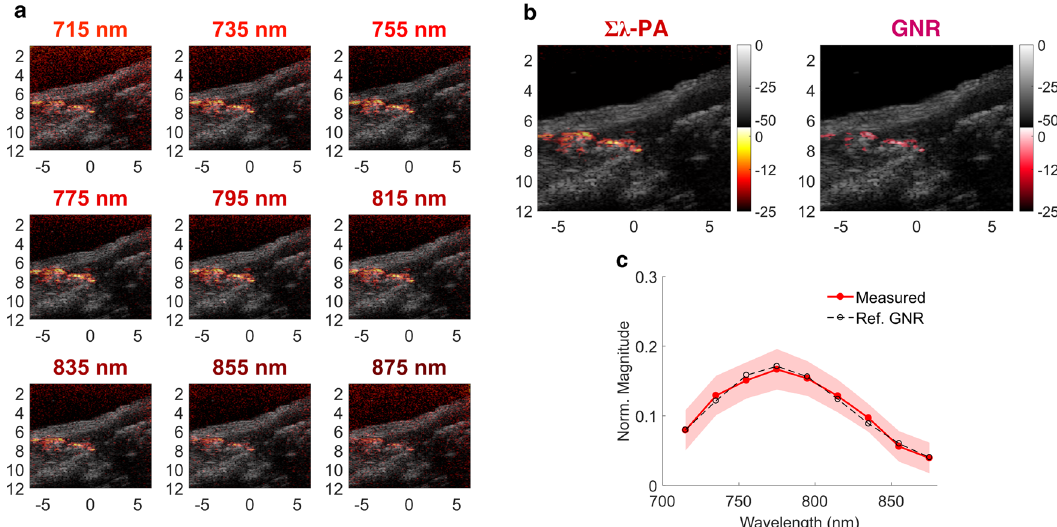
Fig. 6 Case #2 of in vivo spectroscopic imaging for GNR injection into a mouse right leg muscle. Quantitative GNR spectral measurement after motion compensation is illustrated. a Multi-wavelength PAUS image from 715 to 875 nm. b Left: wavelength-compounded Σλ -PA image; right: GNR-weighted PA image. c Measured spectra (normalized to the area under the spectrum) of PA signals larger than − 15 dB are expressed as mean ± standard deviation compared to the UV – VIS result (dashed